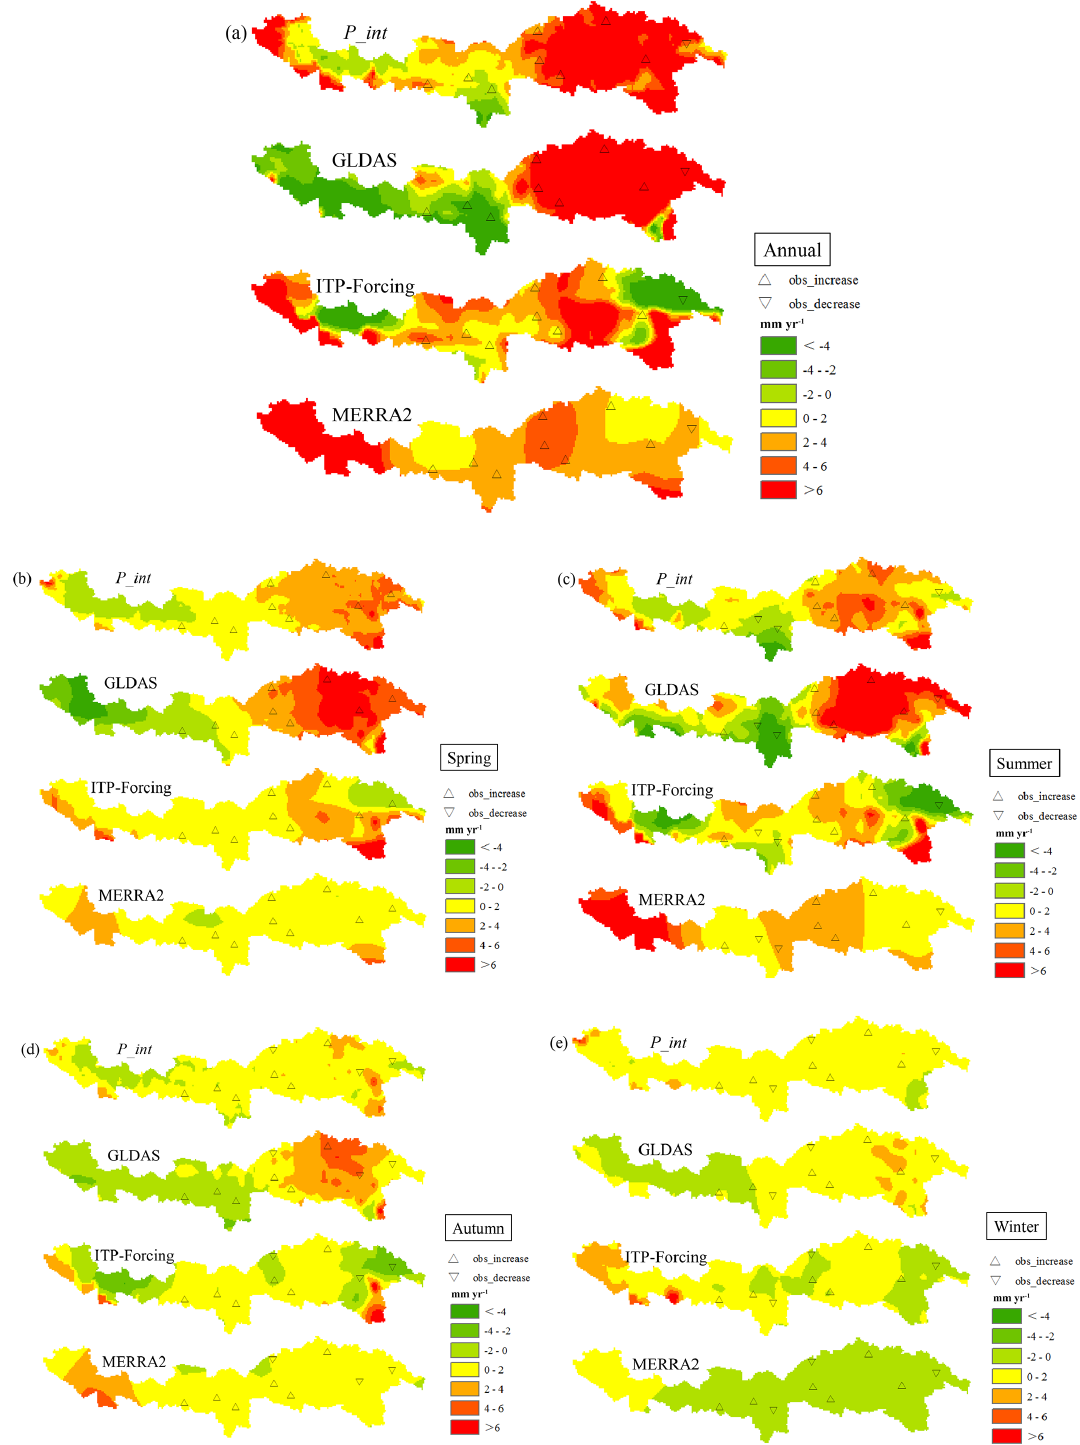
Figure 11. A trend analysis of the annual and seasonal precipitation ( a annual, b spring, c summer, d autumn, e winter) over 36 years (1981– 2016) between P _int, GLDAS, ITP-Forcing, and MERRA2. The triangles represent the observed trend of the corresponding meteorological